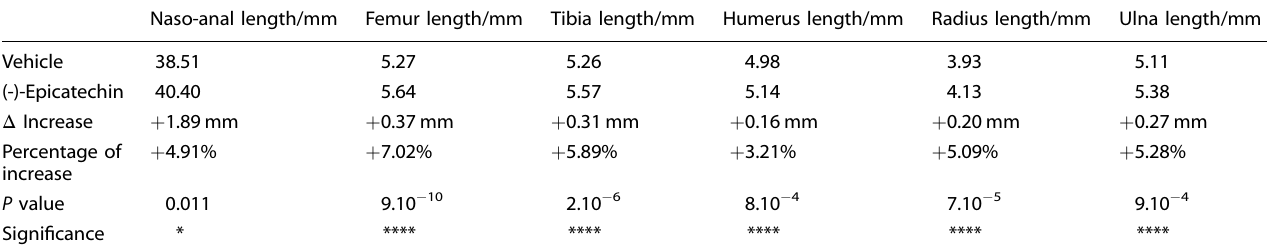
Table 1. (-)-Epicatechin increases bone growth in vivo Naso-anal length/mm Femur length/mm Tibia